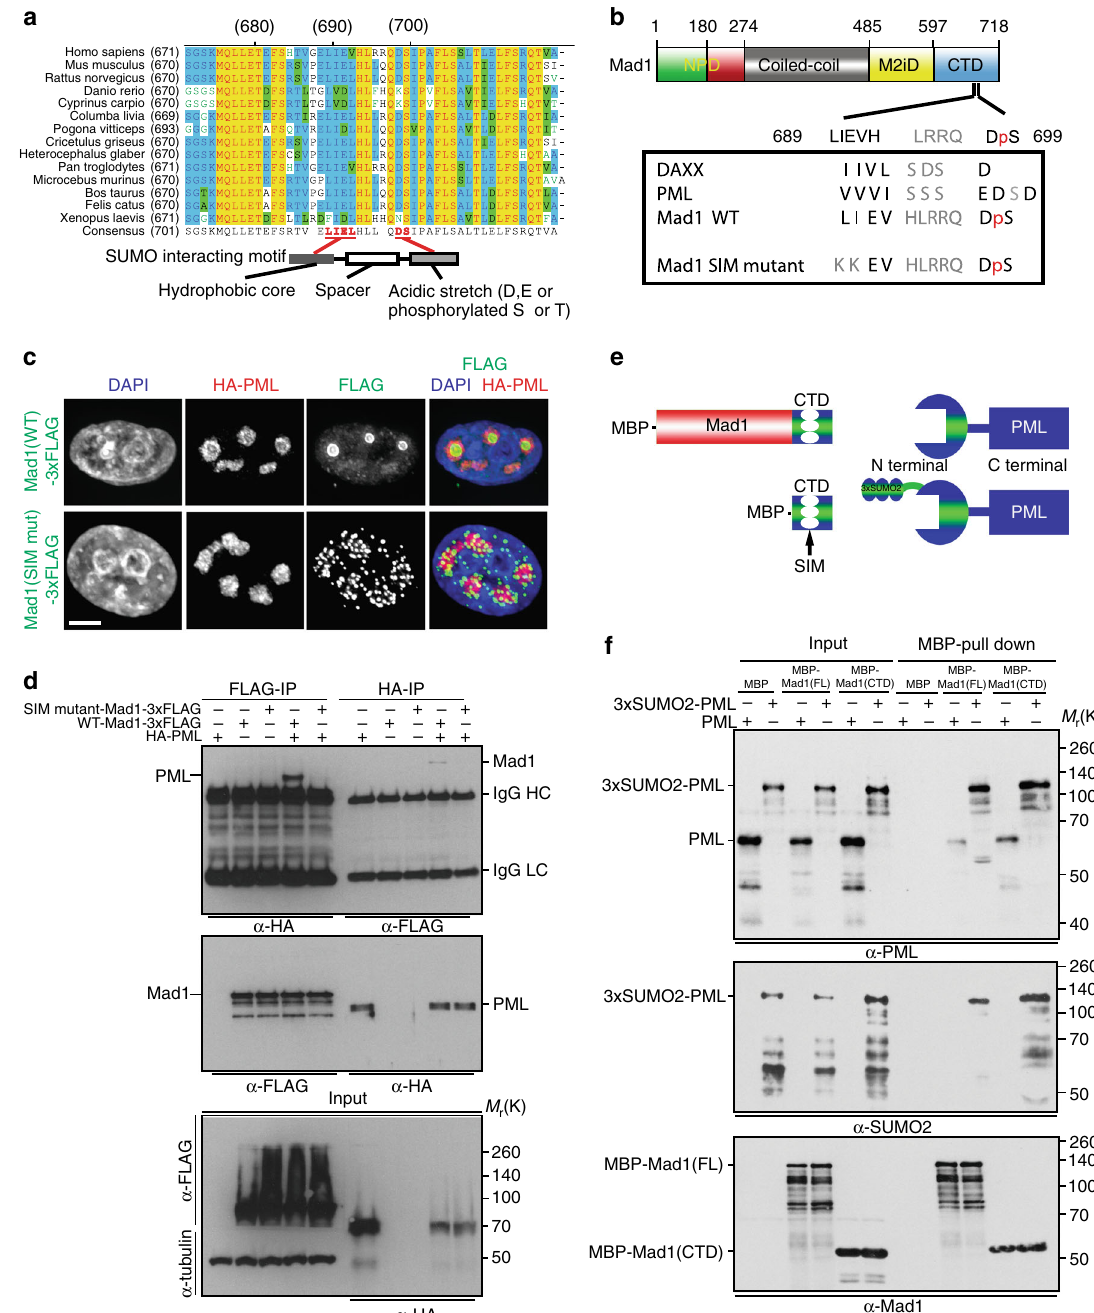
Fig. 3 A conserved SIM within the Mad1 CTD is necessary for Mad1 localization to PML NBs. a Alignment of a portion of the Mad1 CTD protein sequence showing a conserved putative SIM. Residues identical in all species are shown in yellow. Residues conserved in a majority of species are shown in blue. Functional components of SIMs are shown in the schematic underneath. Putative Mad1 SIM residues conserved between species are shown in bolded red font. b Sequence alignment of the putative SIM within the Mad1 CTD and known SIMs in PML and DAXX. Red lowercase p indicates the serine is phosphorylated. c Mutation of the SIM disperses Mad1 from PML NBs. HeLa cells co-transfected with FLAG-tagged wild type (WT) or SIM mutant Mad1 and HA-tagged PML were analyzed 36 h after transfection using Mad1 and HA antibodies. The leucine and isoleucine residues at positions 689 and 690 were mutated to lysines to generate SIM mutant Mad1. Scale bar, 2.5 µ m. d Reciprocal immunoprecipitations showing the interaction between Mad1 and PML is dependent on the Mad1 SIM. 293T cells were co-transfected with HA-tagged PML and FLAG-tagged WT or SIM mutant Mad1. 48 h later, cells were lysed and FLAG or HA antibodies used for immunoprecipitation. A single fi lm for both experiments is shown. Blot is representative of 3 independent experiments. e Schematic of proteins and protein fragments used in ( f ). Sumoylation of PML was simulated by fusing a 3xSUMO2 chain to the N terminus of PML. f MBP pull-down experiments showing both full length Mad1 and the CTD of Mad1 interact with PML directly and that